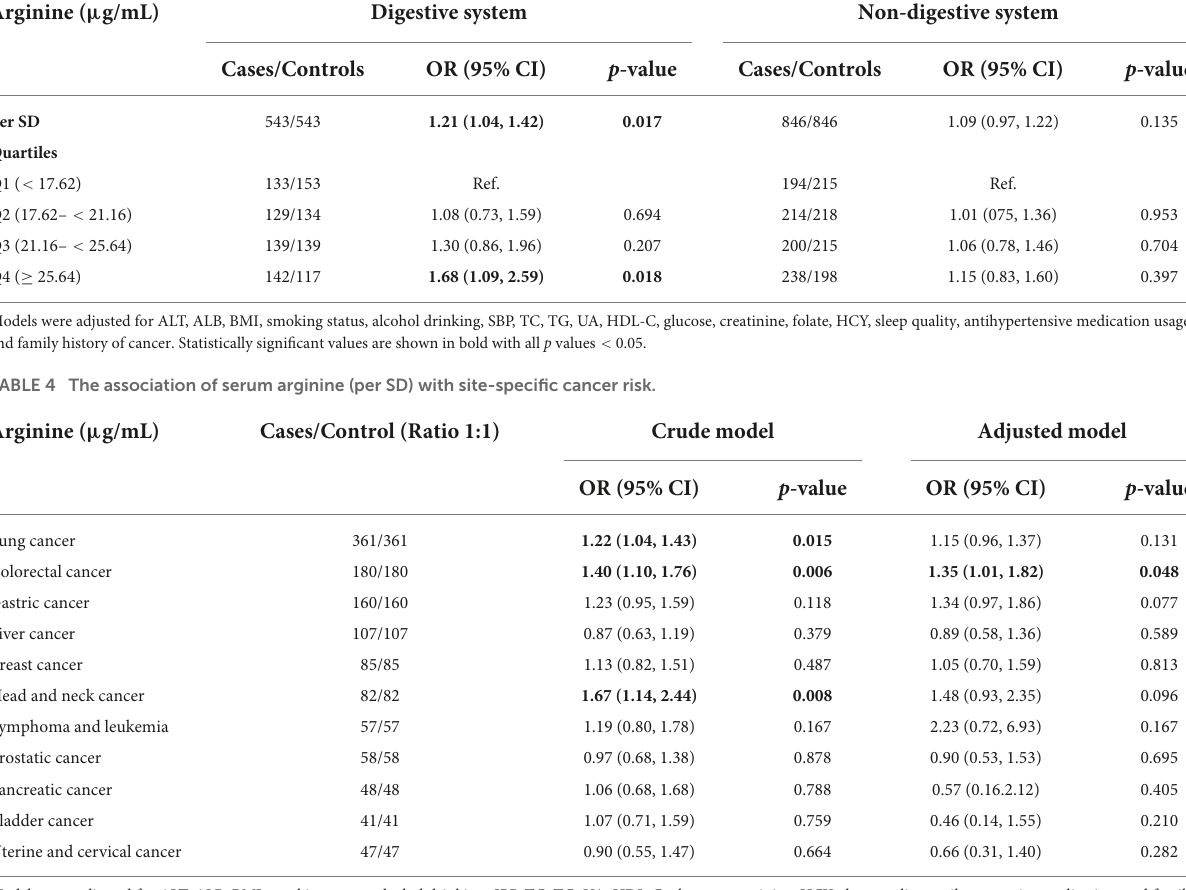
TABLE 3 The association of arginine with the digestive system and non-digestive system cancer risk.